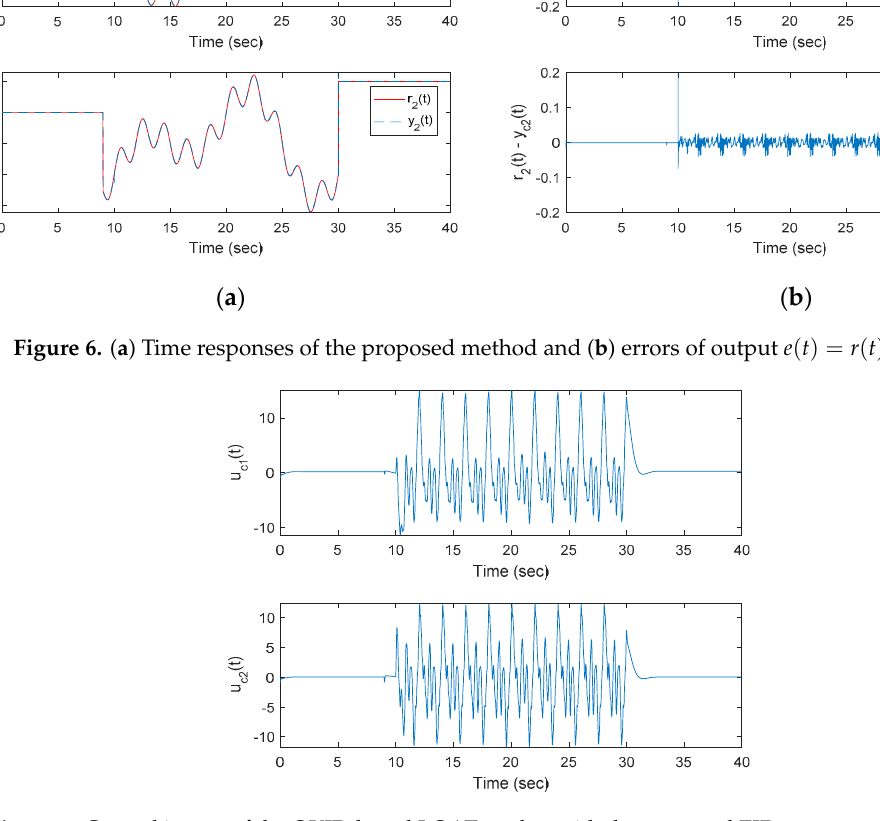
Figure 7. Control inputs of the OKID-based LQAT tracker with the proposed EID compensation for the square system with mismatched input and output